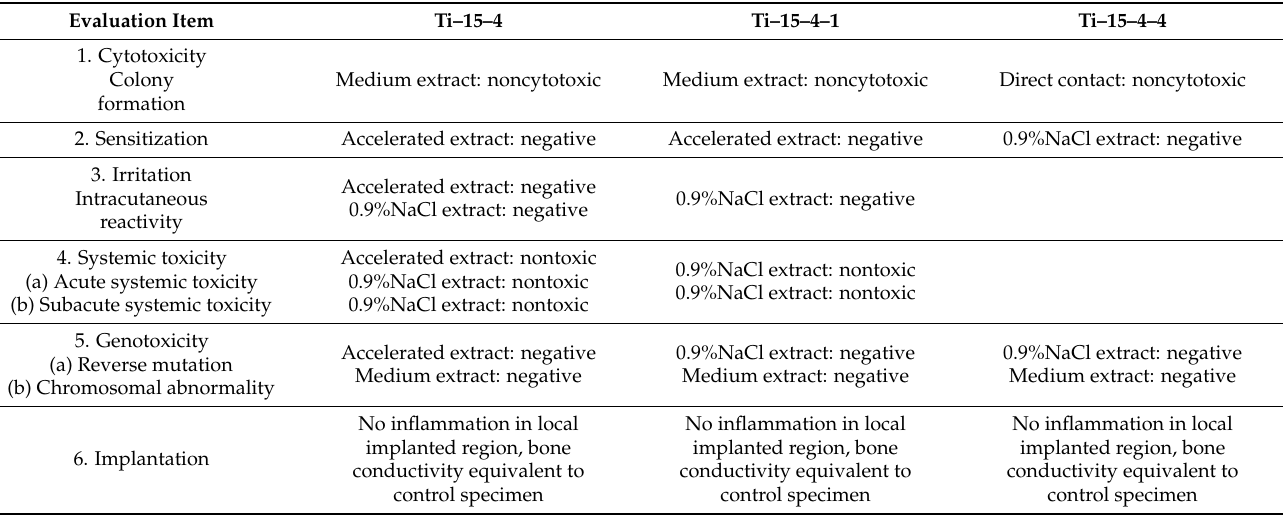
Table 3. Results of biological safety evaluation in accordance with the ISO 10993